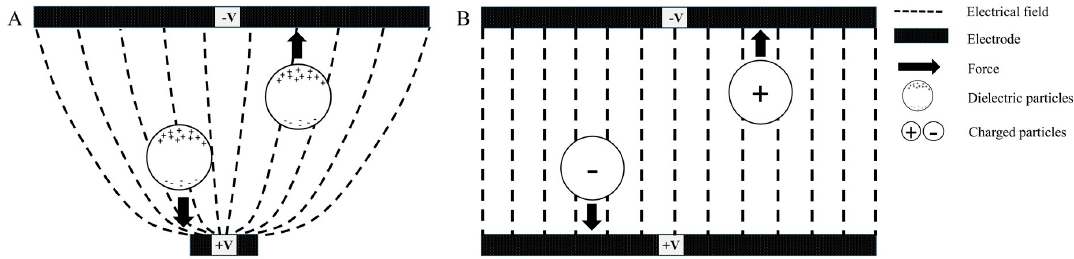
Figure 1. Schematic diagram of DEP vs. EP. ( A ) shows p-DEP and n-DEP effects where the dielectric particles move towards the high and low electric field gradient, respectively; ( B ) shows EP in which cations and anions move towards negative and positive electrode, respectively.